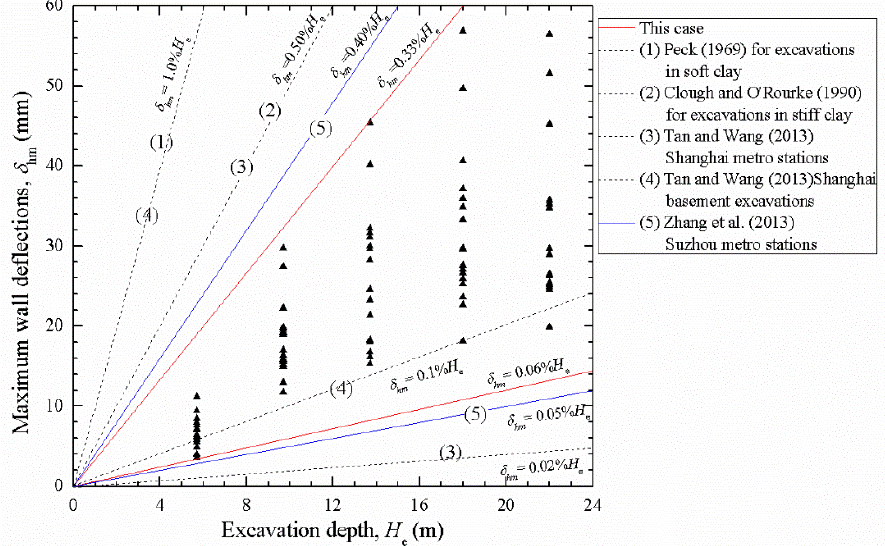
Figure 10. Relationships between excavation depth and maximum wall deflections.